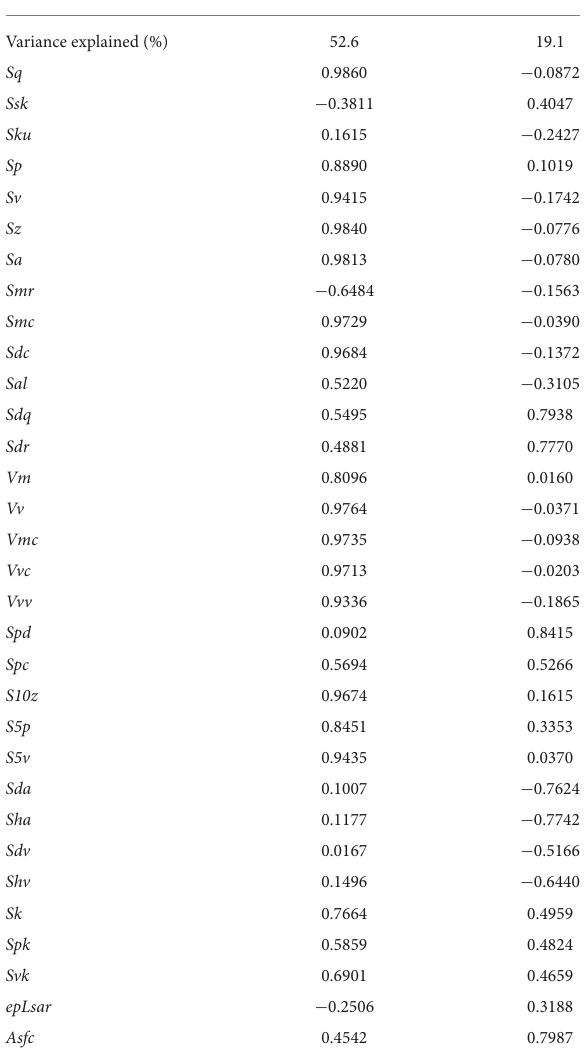
TABLE 4 The factor loadings obtained from a PCA using 32 DMT